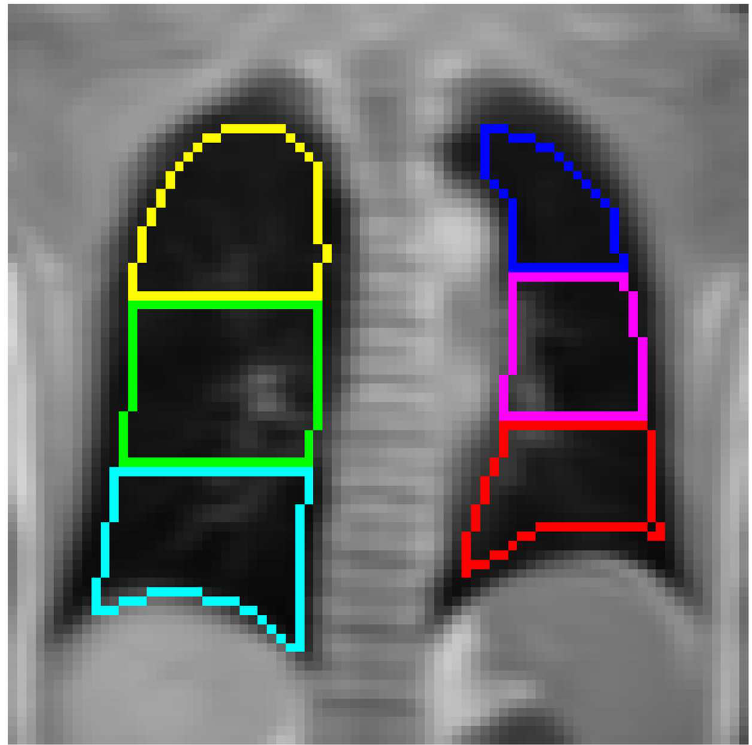
Fig 1. Anterior regions of interest in an asthma patient, generated from a manually drawn mask. ROIs are shown in different colours.